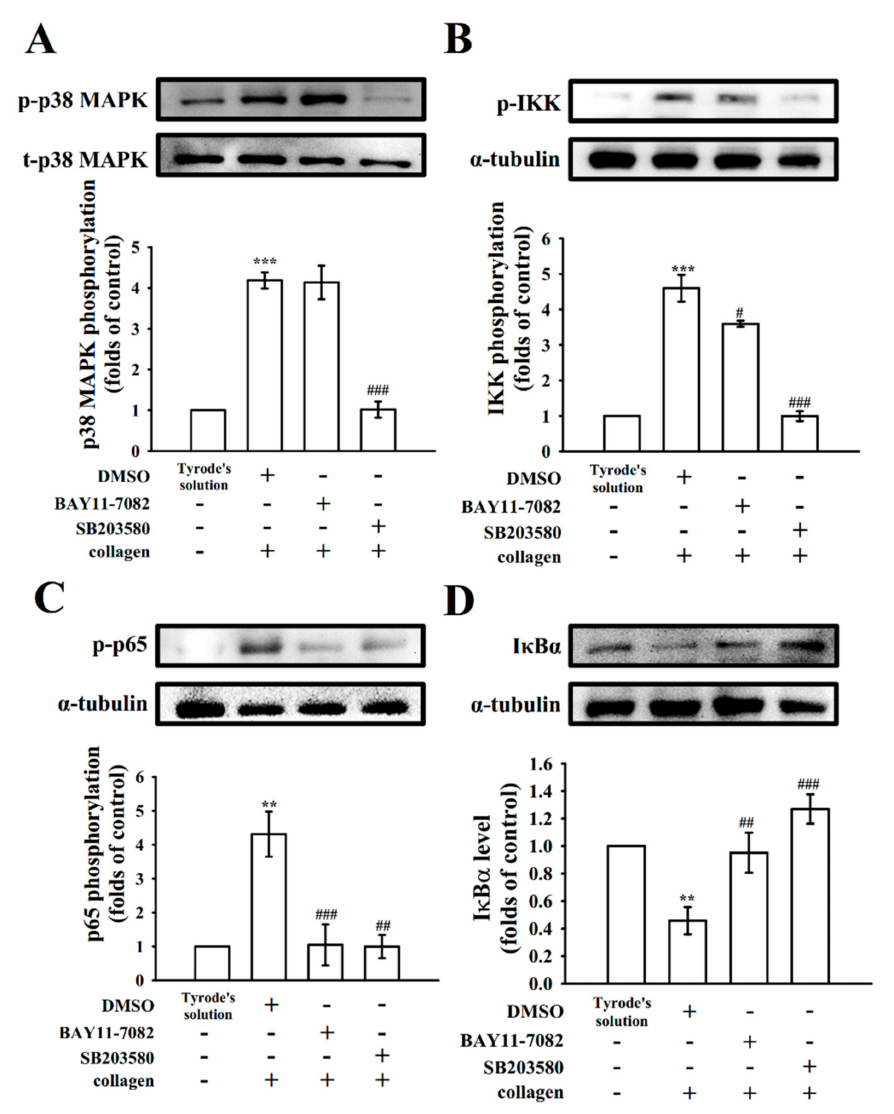
Figure 3. Regulatory role of BAY11-7082 and SB203580 in p38 and NF- κ B activation in platelets. Washed platelets (1.2 × 10 9 cells/mL) were preincubated with a solvent control (0.1% DMSO), BAY11- 7082 (6 µ M), or SB203580 (20 µ M), followed by collagen treatment (1 µ g/mL) to trigger ( A ) p38, ( B ) IKK, and ( C ) p65 phosphorylation or ( D ) I κ B α degradation for the immunoblotting study. Data are presented as the mean ± standard error of the mean ( n = 4). ** p < 0.01, and *** p < 0.001, compared with the resting control (group treated with Tyrode’s solution); # p < 0.05, ## p < 0.01, and ### p < 0.001, compared with the 0.1% DMSO-treated